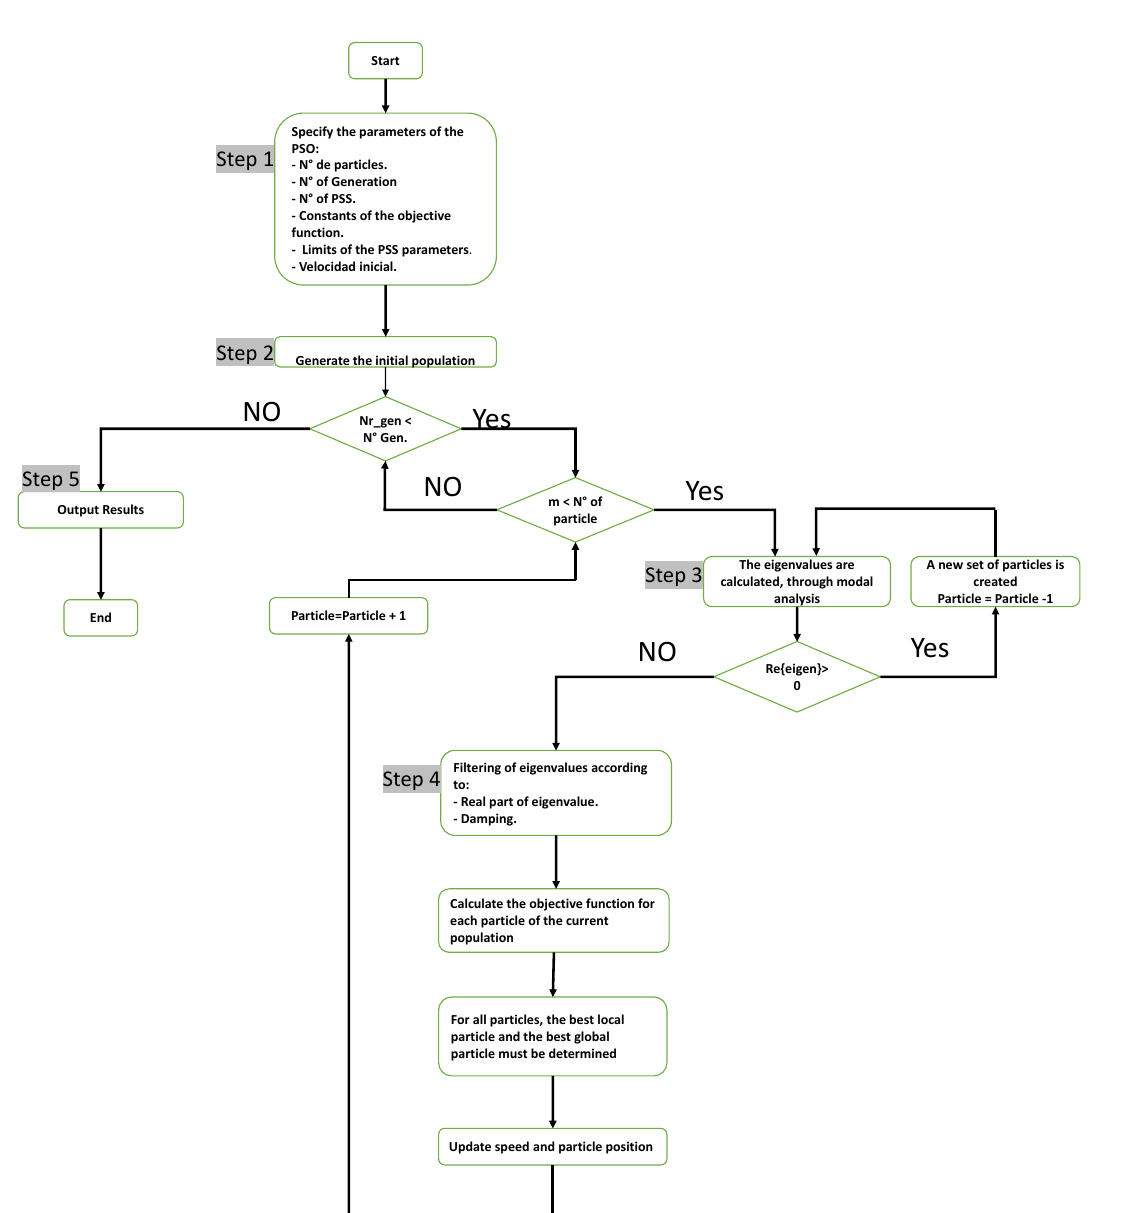
Figure 2. Particle swarm optimization (PSO)